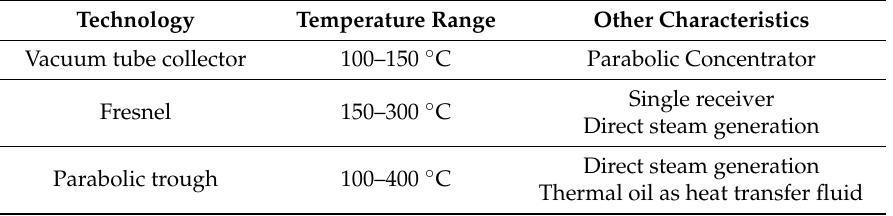
Table 13. Temperature ranges and characteristics of each solar technology.